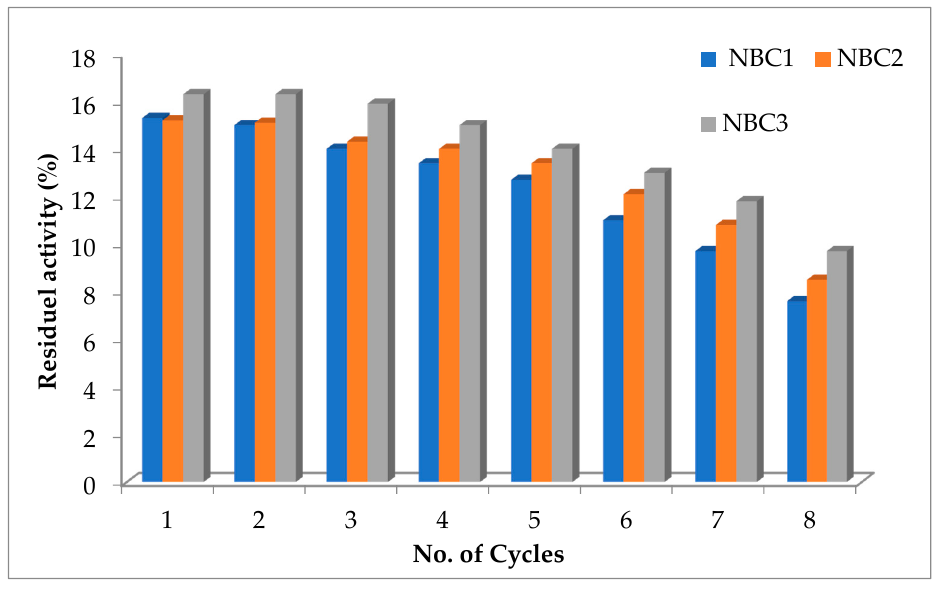
Figure 7. Reusability of NBC lipases. Table 1. Summary of model fitness.